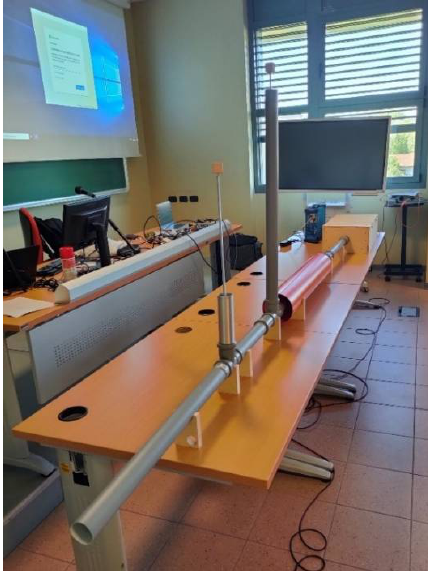
Figure 15. Practical implementation of the sketch reported in Figure 14. The source is placed at the right side and the outlet at the left side.